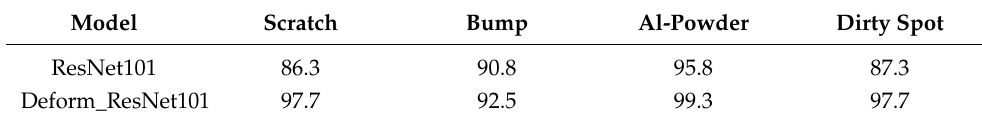
Table 5. Precision rate of model on validation set (%).